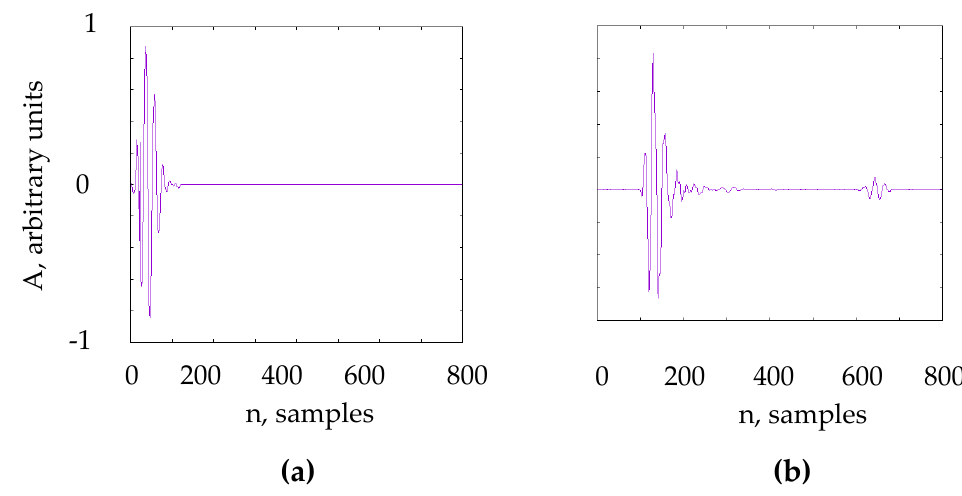
Figure 2. ( a ) A typical input pulse A_n; and ( b ) a typical A-scan